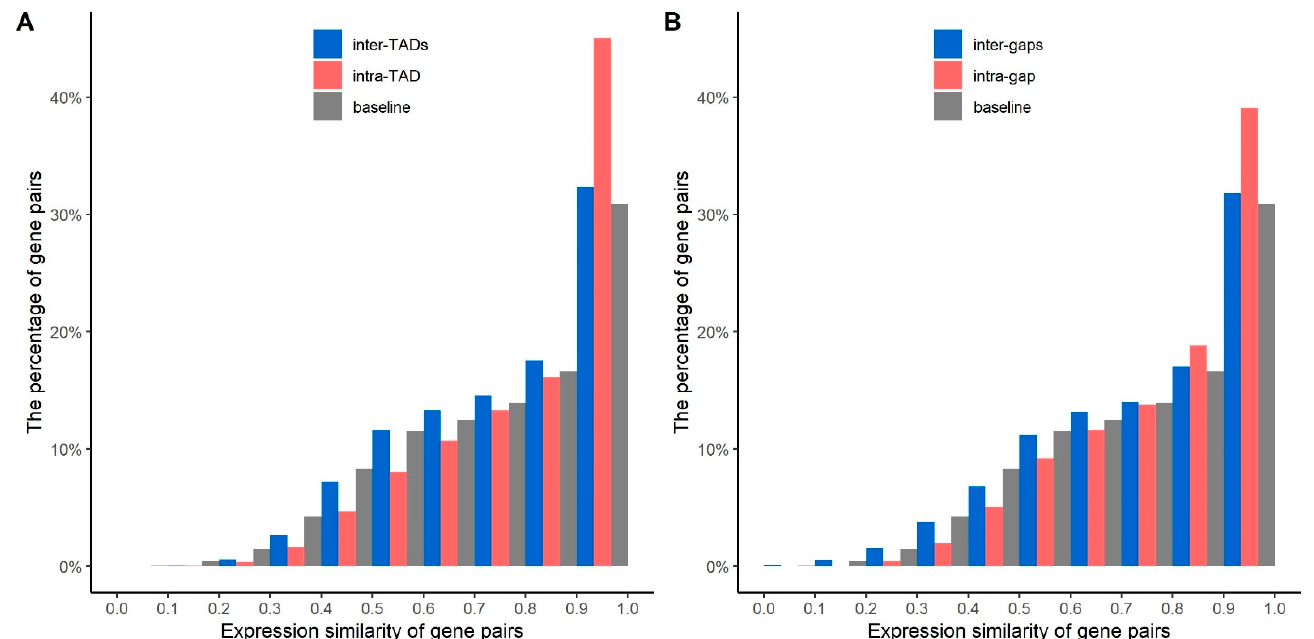
Figure 3. Histograms of expression similarities between gene pairs. ( A ) shows the expression similarities between gene pairs from intra-TAD, inter-TADs, and baseline. ( B ) shows the expression similarities between gene pairs from intra-gap, inter-gaps, and baseline. The baseline indicates that the gene pairs were randomly selected from TADs or gap regions. Table 1. The Pearson’s correlations between functional similarities and expression similarities (func- tional threshold >0.2). Only two Pearson’s correlations have >0.05 p -values ( p -value listed in paren- thesis). All other correlations have <0.05 p